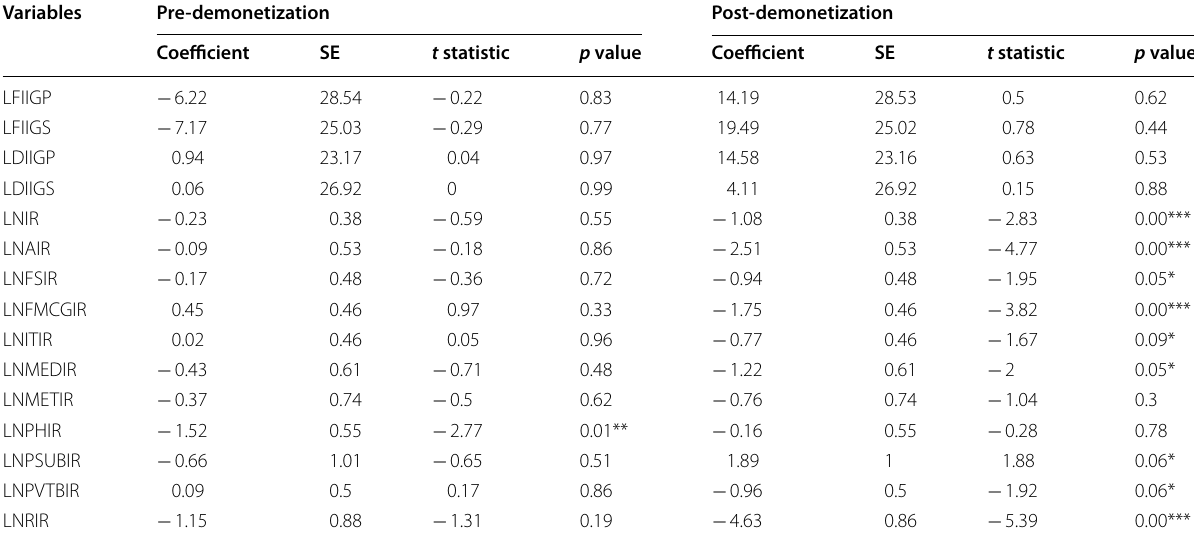
Table 4 Analysis showing impact of demonetization on FIIs, DIIs and stock market returns. Source : Author’s compilation